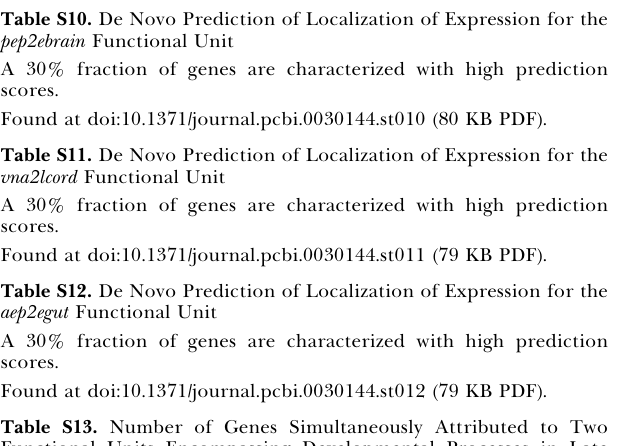
Table S17. Diversity of Anatomical Annotations of Genes Comprising the Functional Unit aep2egut Found at doi:10.1371/journal.pcbi.0030144.st017 (104 KB PDF). Table S18. Diversity of Anatomical Annotations of Genes Comprising the Functional Unit